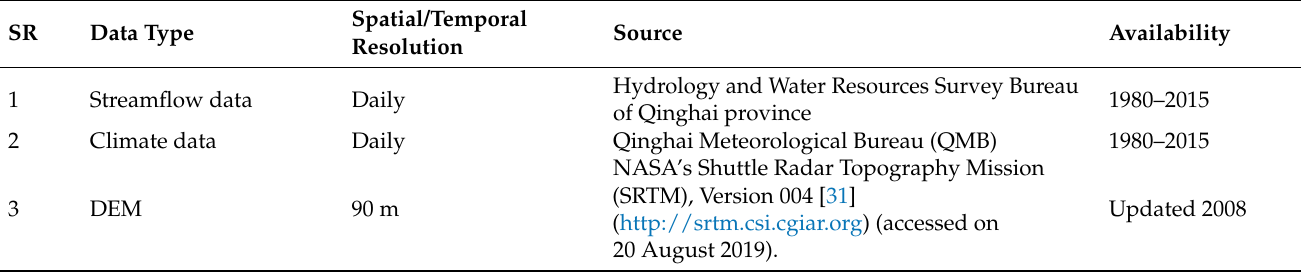
Table 1. Spatial and temporal data used in the present study.